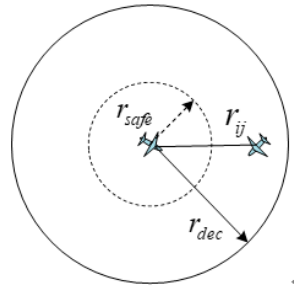
Figure 4. Reference distance of UAV.